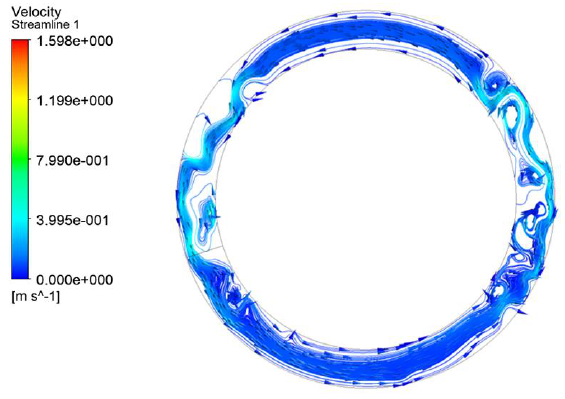
Figure 15. Streamline in 2D simulation after 200 s, VF = 40%.